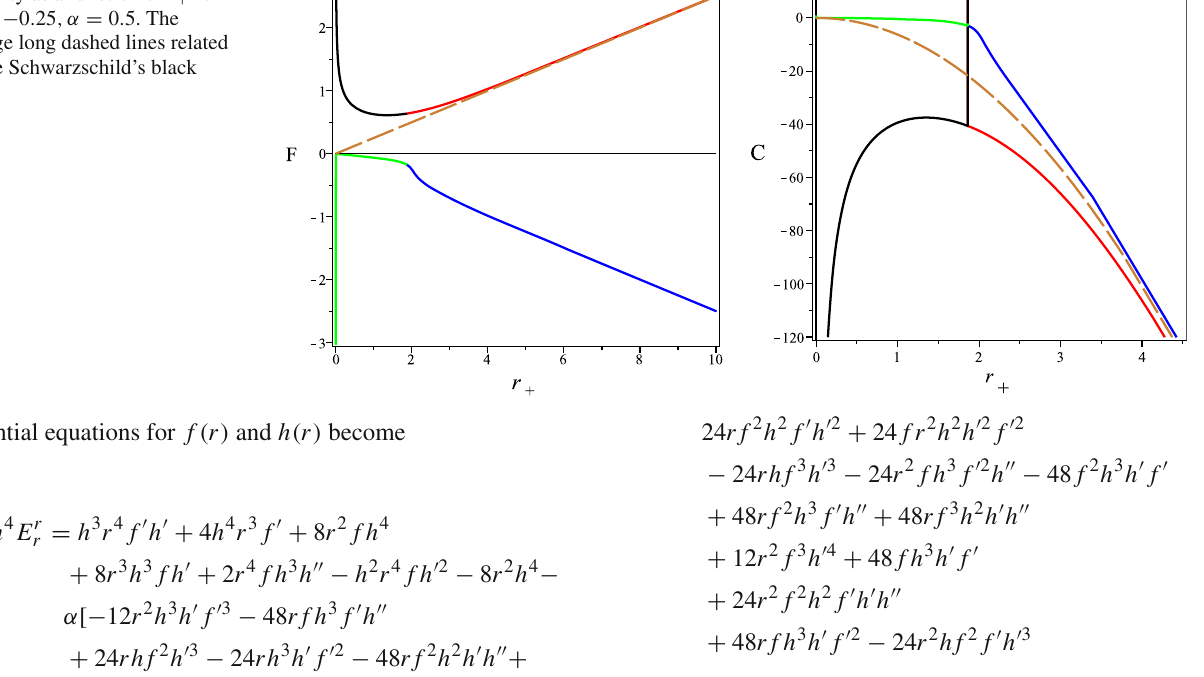
= h 3 r 4 f (cid:4) h (cid:4) + 4 h 4 r 3 f (cid:4) + 8 r 2 f h 8 r 4 h 4 E r r